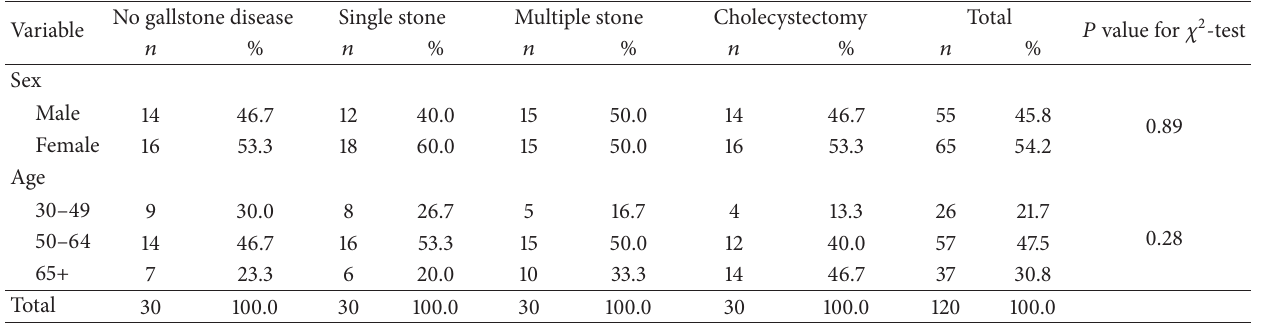
Table 1: The gender and age distribution of the utility survey among outpatient clinics participants ( 𝑛 = 120 ). Variable